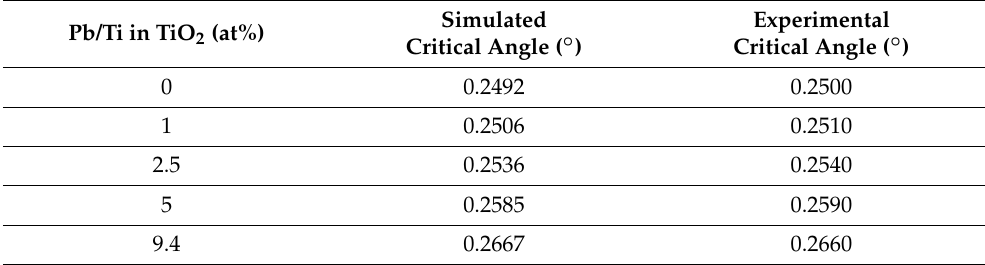
Table 2. Atomic percentage of Pb/Ti in Pb X Ti (1 − x) O 2 with respective critical